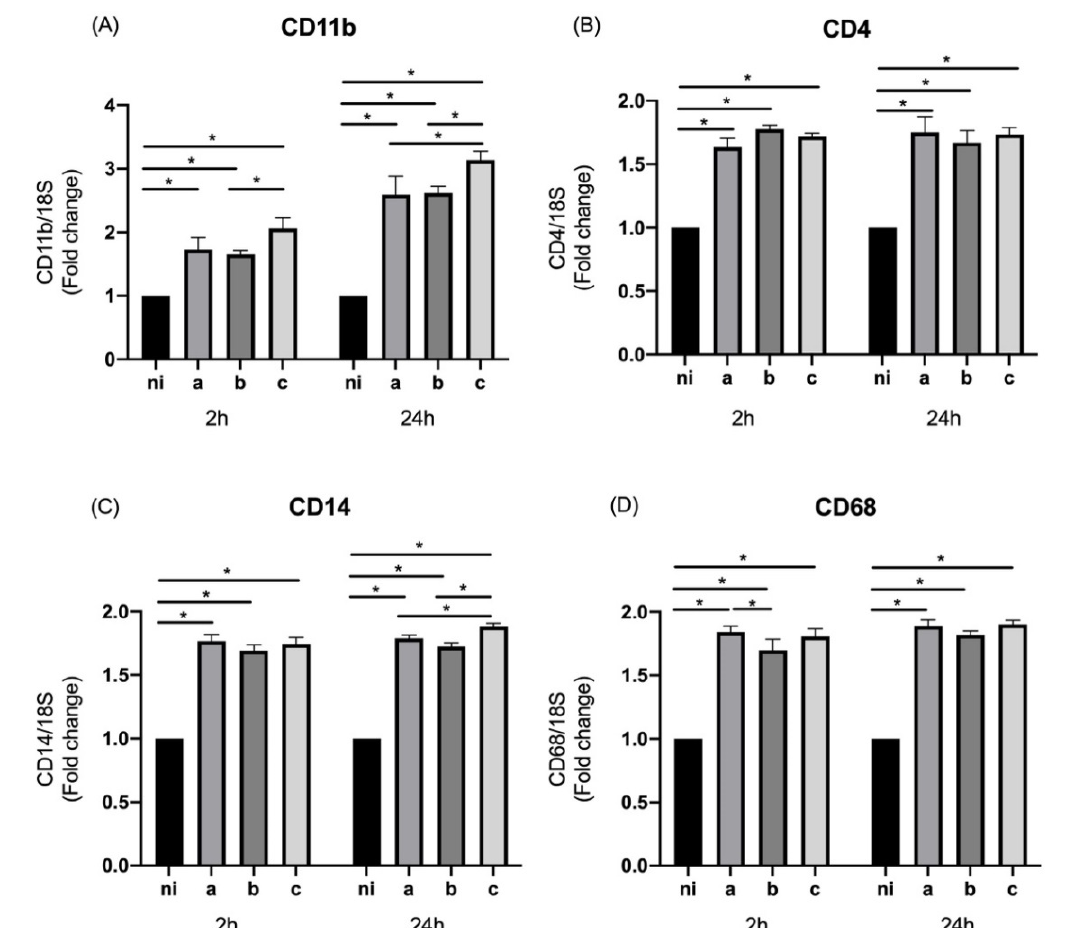
Figure 1. M0 markers’ expression by Aggregatibacter actinomycetemcomitans -induced THP-1 human macrophages (ATCC ® TIB-202TM). Expression in macrophages infected at an MOI = 102 with strains ATCC ® 43717TM (serotype a), ATCC ® 43718TM (serotype b), and ATCC ® 43719TM (serotype c), 2 and 24 h after infection. For relative expression, mRNA expression in non-infected (ni) macrophages was considered as 1, as a reference for fold-change in expression using 18S rRNA expression levels as a normalizing endogenous control. Data are represented as fold-change means and standard deviation of three independent experiments performed in duplicate. Asterisks were used to indicate a value of p considered statistically significant (* p < 0.05).